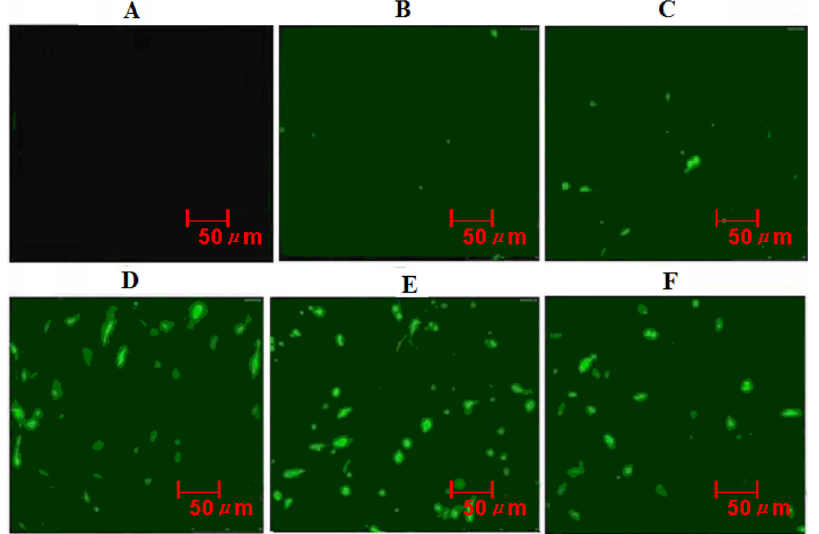
Figure 2. Fluorescence profile of hepatic stellate cells (HSCs) transfected with the Smad3 siRNA expression vector labeled with green fluorescent protein (GFP). A , Normal control HSCs; B - F , HSCs transfected with siRNA expression plasmids at 0.4, 0.6, 0.8, 1.0, 1.2 µg plasmids/10 6 cells, respectively. The expression of GFP in E (1.0 µg plasmids/10 6 cells) is powerful, which is a more suitable